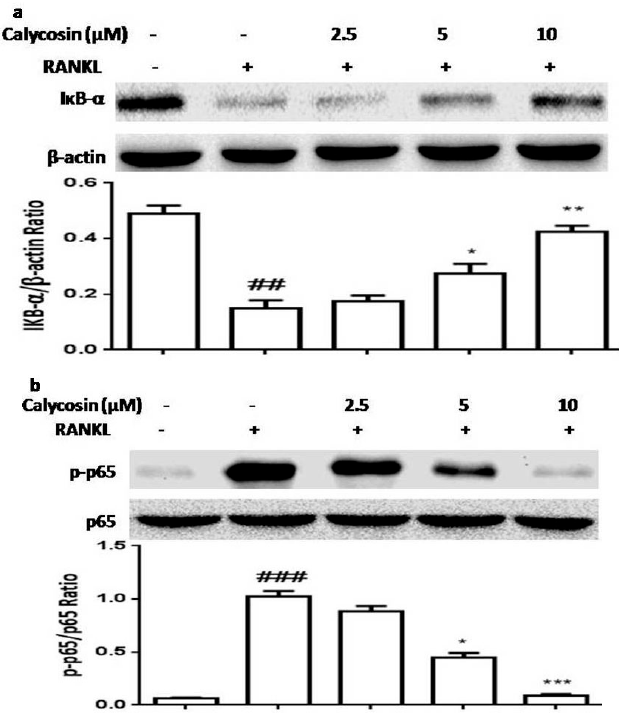
Figure 5. Effects of calycosin on the activation of NF- κ B by RANKL. BMMs were pretreated with the indicated dose of calycosin or DMSO (vehicle) for 20 min, then RANKL (20 ng/mL) was added for 30 min. ( a ) The effects of calycosin on the degradation of I κ B- α ; and ( b ) the effects of calycosin on the phosphorylation levels of NF- κ B p65 subunit. The relative quantification of target proteins was calculated by comparison of the bands density levels between samples. The values shown in the graphs were the mean ± SD ( n = 3). ## p < 0.01 and ### p < 0.001 vs. vehicle-treated group; * p < 0.05; ** p < 0.01; *** p < 0.001 vs. RANKL-treated group.